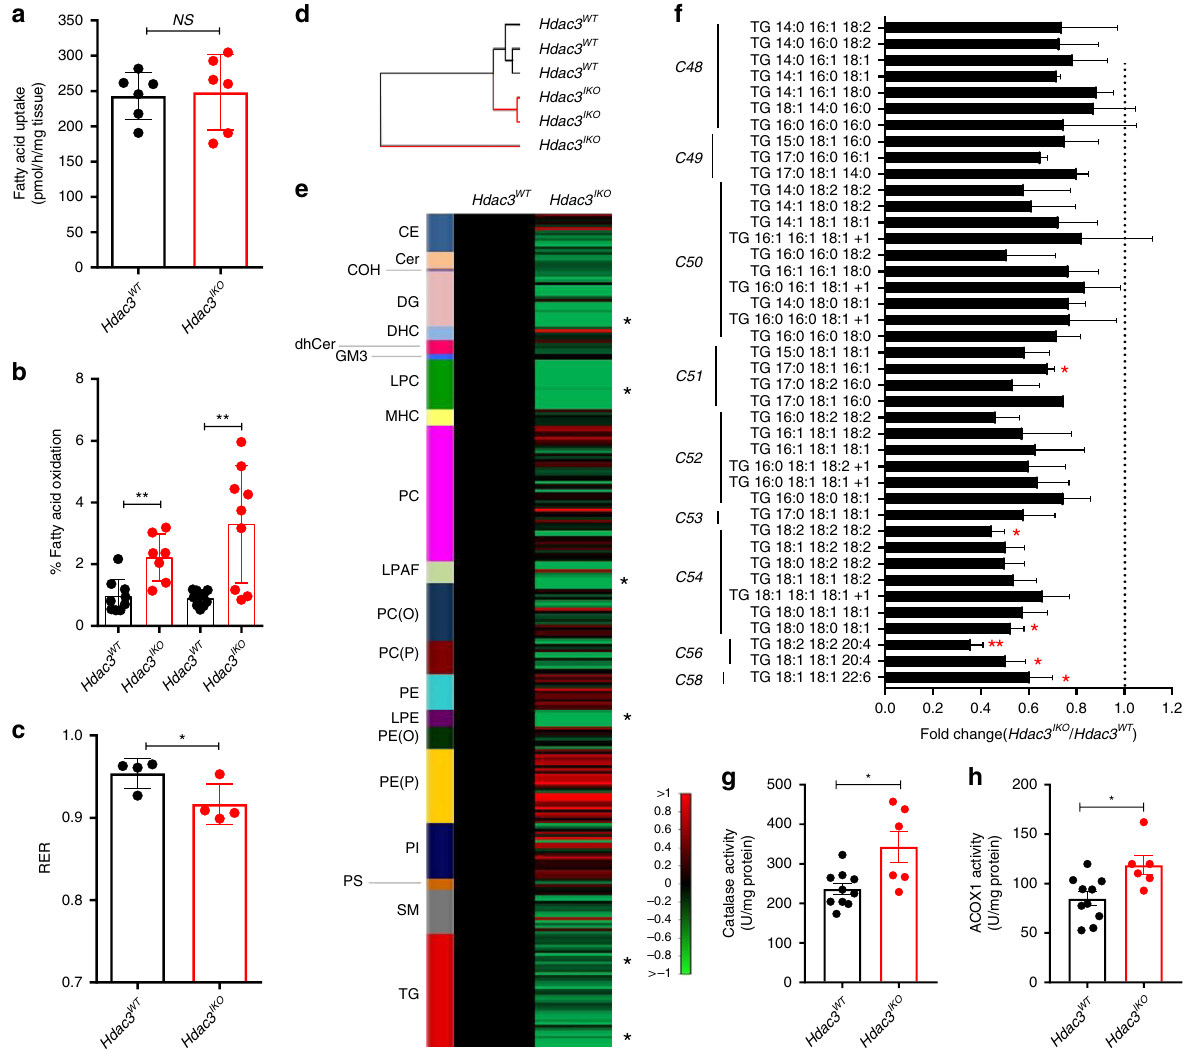
Fig. 4 Deletion of HDAC3 increases lipid oxidation and remodels the lipidome of enterocytes. a Fatty acid uptake and ( b ) fatty acid oxidation assessed ex vivo in segments of the duodenum isolated from the small intestine of 4 – 6-week-old Hdac3 WT and Hdac3 IKO male mice fed a standard diet. Values shown are mean ± SD of individual tissue preparations generated from n = 6 mice ( a ) and n = 3 mice in triplicate ( b ) (NS not signi fi cant, ** P < 0.005, unpaired t test). c Respiratory exchange ratio (RER) measured over 24 h in 4 – 6-week-old Hdac3 WT and Hdac3 IKO male mice fed a standard diet. Mice were individually housed and the RER (VO2/VCO2) determined by indirect calorimetry. Values shown are mean + SD of n = 4 mice, * P < 0.05, unpaired t test. d , e Pro fi ling of the lipidome of IECs isolated from the entire small intestine of 4 – 6-week-old male Hdac3 WT and Hdac3 IKO mice fed a standard chow diet. d Unsupervised cluster analysis of samples based on abundance of 302 lipid species pro fi led in IECs isolated from Hdac3 WT and Hdac3 IKO mice. e Differential abundance of lipid species in IECs isolated from male Hdac3 WT and Hdac3 IKO mice. Data shown in the heatmap are the mean of n = 3 mice per genotype, * P < 0.05, unpaired t test. f Fold change in individual triglyceride (TG) species of different aliphatic chain length in Hdac3 IKO mice. Values shown are mean ± SEM of n = 3 mice per genotype, * P < 0.05, unpaired t test. g , h Catalase ( g ) and ACOX1 ( h ) enzymatic activity in IECs isolated from the entire small intestine from 4 – 6-week-old mice fed a standard chow diet. Values shown are mean ± SD of individual tissue preparations generated from n = 10 Hdac3 WT and n = 6 Hdac3 IKO mice, * P < 0.05, unpaired t